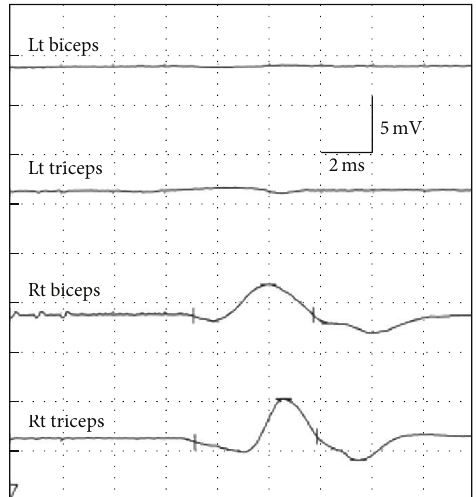
Figure 2: Changes in CMAP of the bilateral biceps and triceps after spinal cord hemisection. Amplitudes of the left biceps and triceps were disappointed.